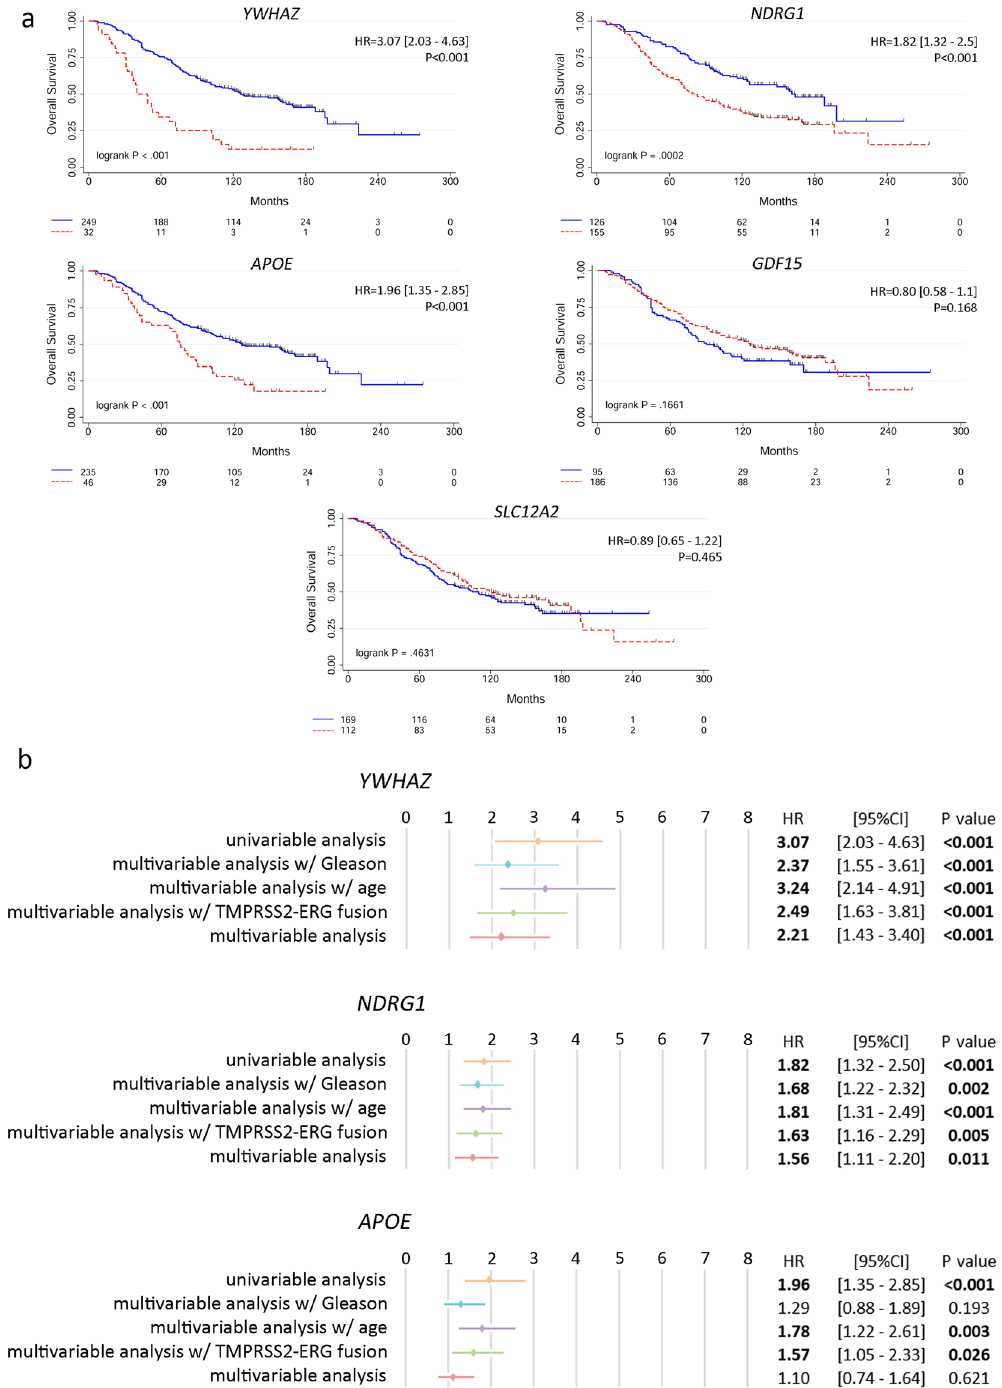
Fig. 3 Overall survival (OS) of PCa patients naive of treatment based on YWHAZ , NDRG1 , APOE , GDF15 , and SLAC12A2 expression ( Sboner data set, GSE16560, n = 281). a Kaplan – Meier curves for OS for PCa patients segregated based on the gene expression levels for YWHAZ , NDRG1 , APOE , GDF15 and SLAC12A2 . OS of patients with high (red dotted-lines) vs. low (blue full-lines) expression for each gene. b Multivariable analyses presented by forest plots including each gene with GS, age or TMPRSS2-ERG fusion or all the variables together. Statistical signi fi cant associations are bolded. Multivariable analysis w/Gleason (light blue) = adjusted for GS (6; 7 (3 + 4); 7 (4 + 3); 8 – 10). Multivariable analysis w/age (purple) = adjusted for age at diagnosis (age groups: 50 – 70; 70 – 80; 90 – 100). Multivariable analysis w/ TMPRSS2-ERG fusion (green) = adjusted for TMPRSS2-ERG fusion. Multivariable analysis (red) = adjusted for GS, age at diagnosis and TMPRSS2-ERG fusion. GS = Gleason score. HR = hazard ratios [95% con fi dence interval] for the univariable analysis. All comparisons consider low expression patients as the reference group. P = Cox proportional hazard model P -value. Statistical signi fi cance was set at P ≤